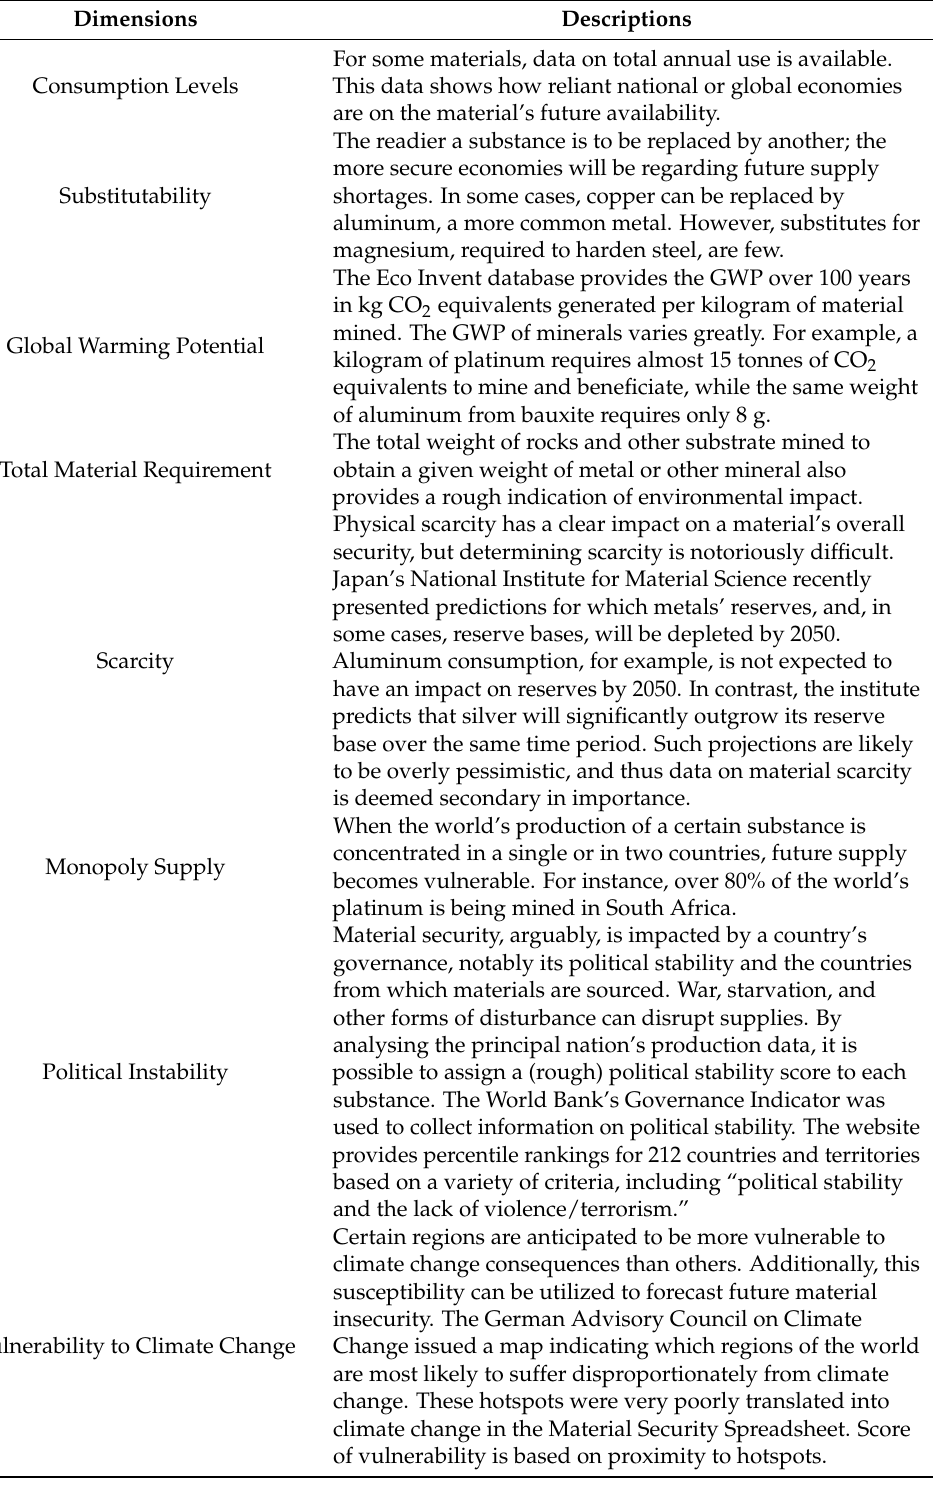
Table 2. Descriptions of critical material security indicators, adapted from